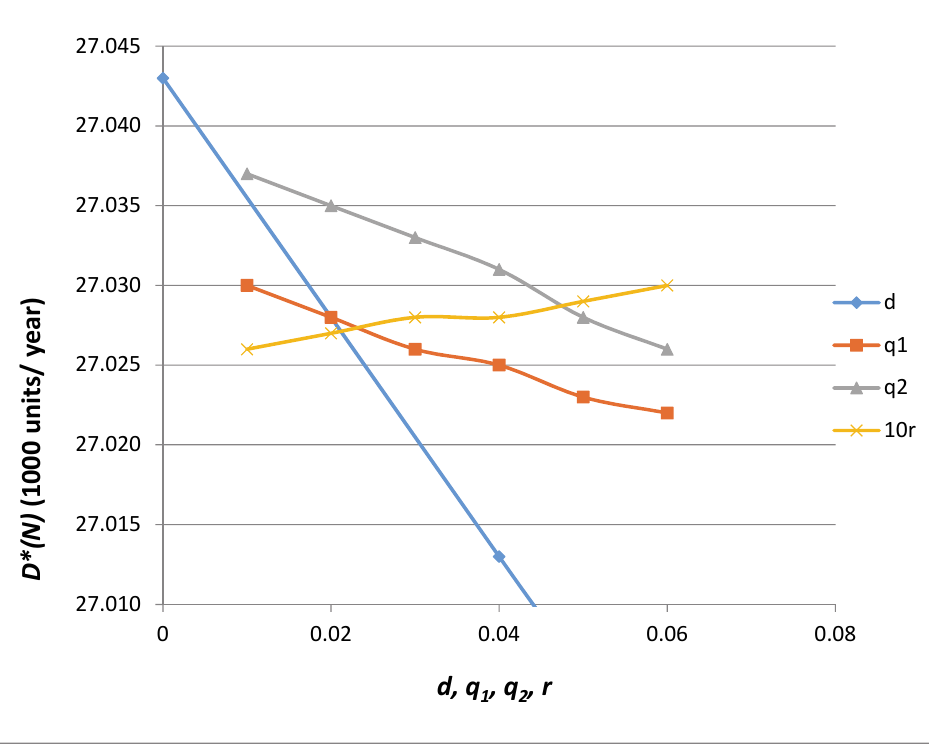
Fig. 9. Effect of increase in different parameters viz. d, q 1 , q 2, r on D* ( N )